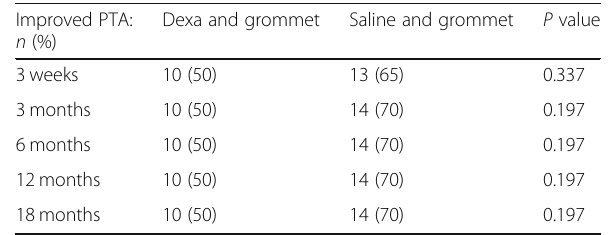
Table 2 Comparing the groups IT Dexa and Dexa